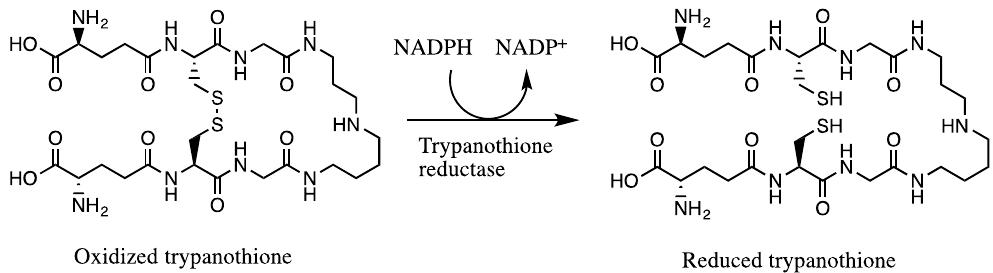
Figure 5. Reduction of oxidized form of trypanothione by trypanothione reductase with NADPH.